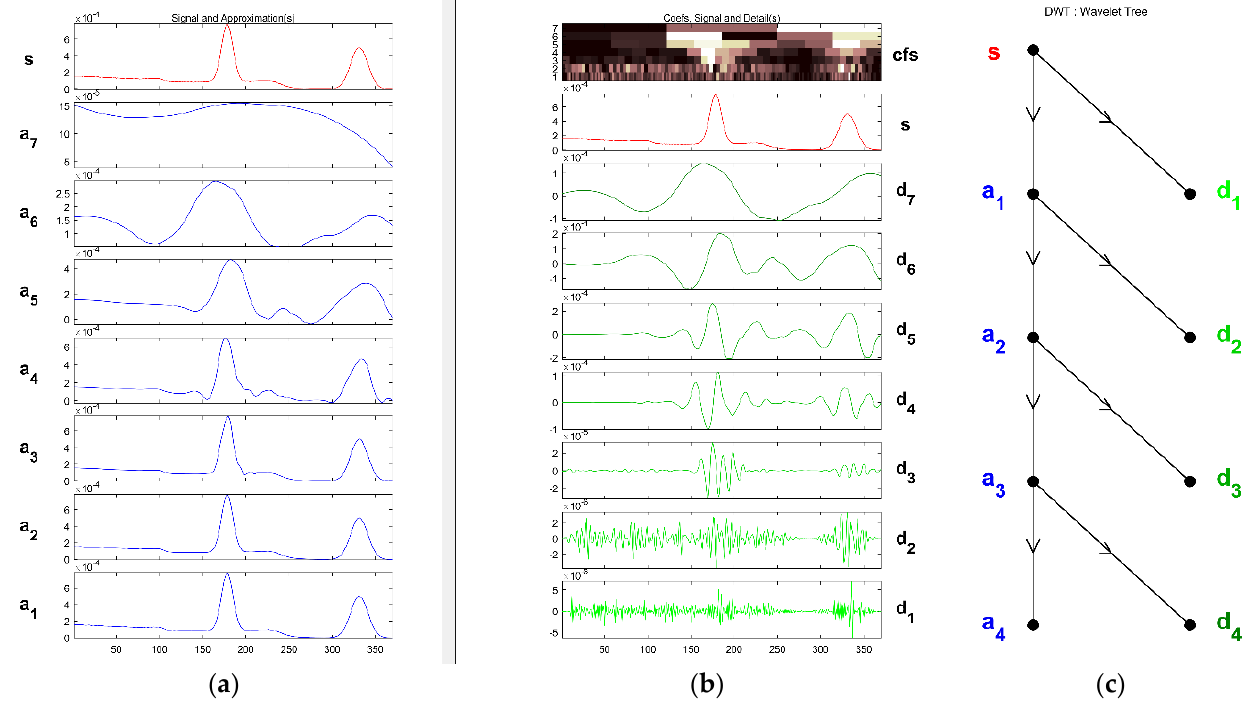
Figure 4. ( a ) Approximation signals, ( b ) detail signals, and ( c ) wavelet tree.